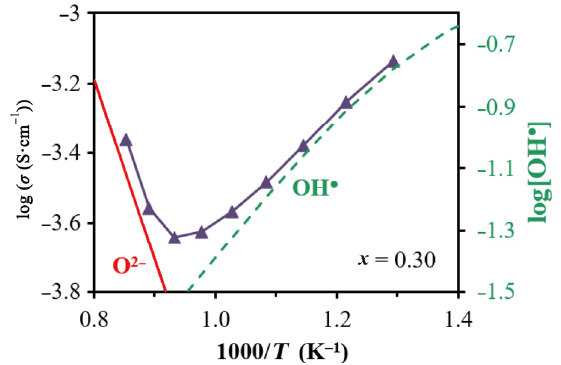
Fig. 6 Temperature dependence of the BaSn 1 − x Sc x O 3 − δ total σ in humidified hydrogen (the left axis) and the proton concentration at p (H 2 O) = 0.03 atm (the right axis).